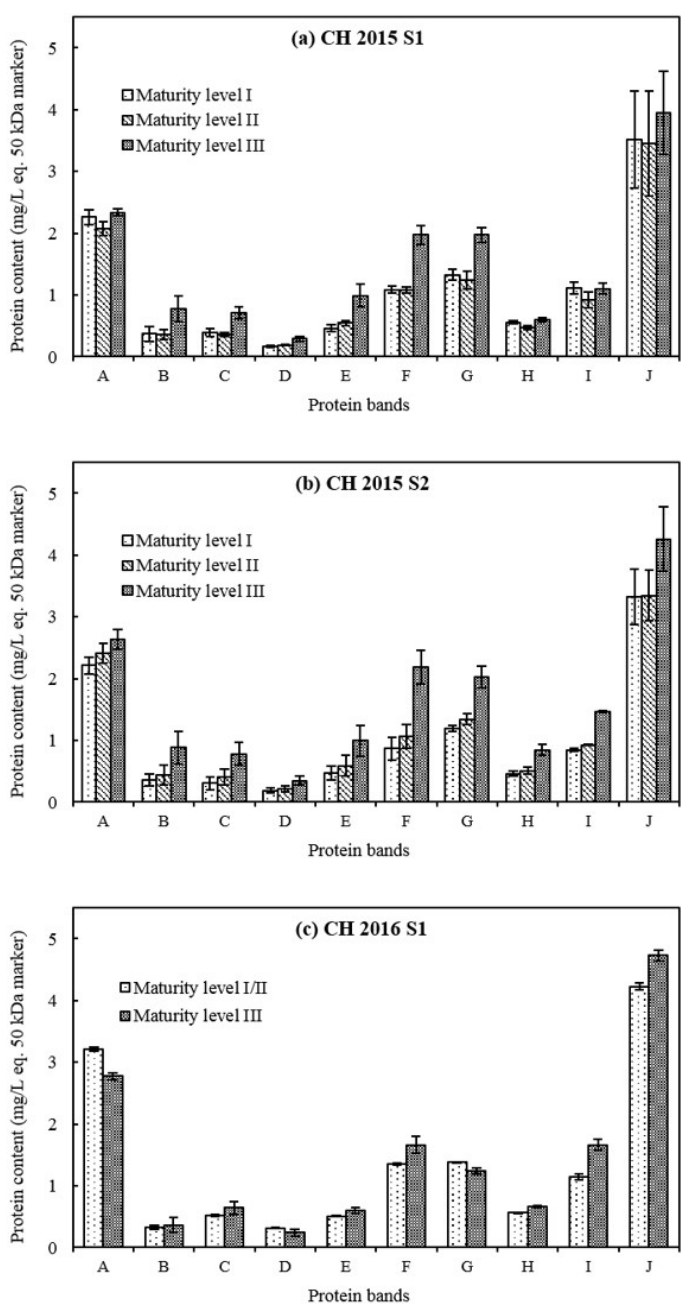
Figure 3. Concentrations of 10 major wine protein bands from Chardonnay (CH) S1 ( a ) and S2 ( b ) base wines in vintage 2015, and S1 ( c ) base wines in vintage 2016. Error bars represent the standard deviation of three replicates .